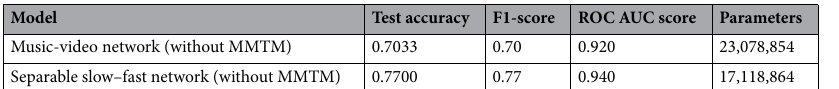
Table 2. Music and video score on test sample after finetuning the unsupervised representation.